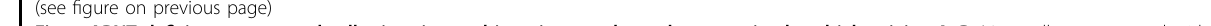
Fig. 5 ARNT de fi ciency-promoted cell migration and invasion are dependent on mitochondrial activity. A – B A375 cells were treated with CCCP (10 μ M) and rotenone (1 μ M) for overnight. The cell lysates were prepared and subjected to SDS-PAGE and then analyzed by Western blotting with antibodies against fi bronectin, ARNT and α -tubulin. The migration properties were analyzed by wound-healing assays as described in the “ Supplementary information ” . C A375 cells were treated with NAC (20 mM) for overnight. Cell lysates were prepared and subjected to SDS-PAGE and then analyzed by Western blotting with antibodies against phosphorylated FAK Y397 , N-cadherin, ARNT and α -tubulin. D A375 cells were transfected with expression vectors including empty vector and mitochondrial-targeted catalase (M-CAT) 58 . Cell lysates were prepared and subjected to SDS- PAGE and then analyzed by Western blotting with antibodies against fi bronectin, ARNT and α -tubulin. E ARNT-depleted cells were treated with EtBr (50 ng/ml) for one week. Mitochondrial and nuclear DNA copy number were measured by quantitative real-time PCR from total genomic DNA extracted from indicated cells. The copy number of mtDNA was normalized by nuDNA (i). Cell lysates were prepared and subjected to SDS-PAGE and then analyzed by Western blotting with antibodies against phosphorylated FAK Y397 , ARNT and α -tubulin (ii). Carboxyl-H 2 DCFDA staining was performed to quantify the ROS levels by fl ow-cytometry (iii). The migration and invasion properties of EtBr-treated shARNT cells were analyzed by trans-well migration and invasion assays. The migrating and invading assays were described in the “ Materials and methods ” section (iv). Values are indicated as the mean ± s.e.m. *** P < 0.001; n.s.: no signi fi cant